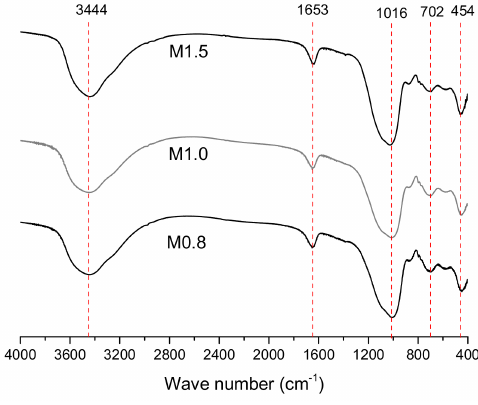
Figure 21. FTIR spectra of 28-day geopolymer